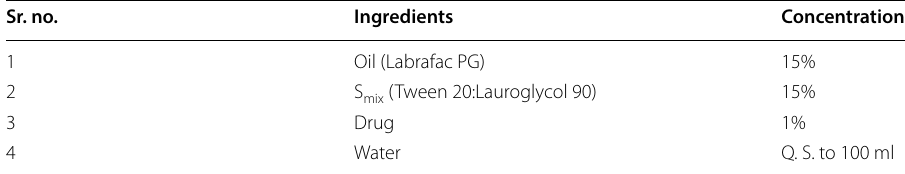
Table 1 Optimized nanoemulsion batch Sr.